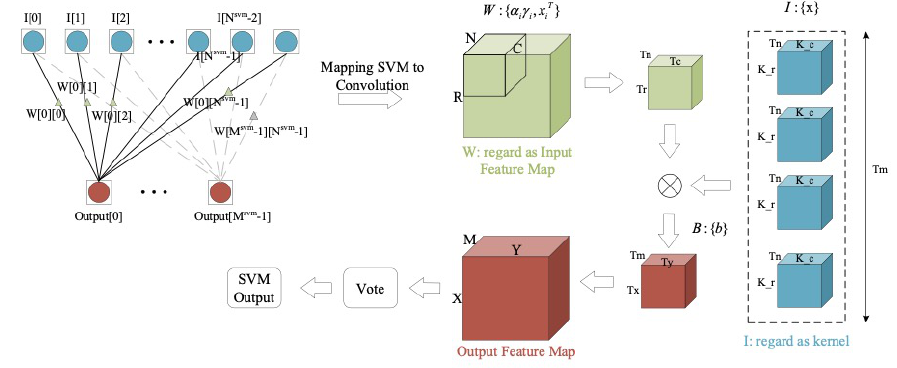
Figure 6. Implementation of SVM.